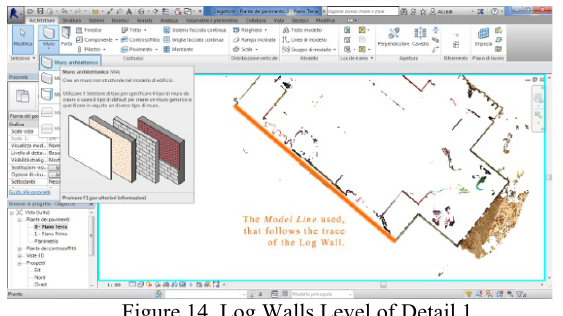
Figure 14. Log Walls Level of Detail 1